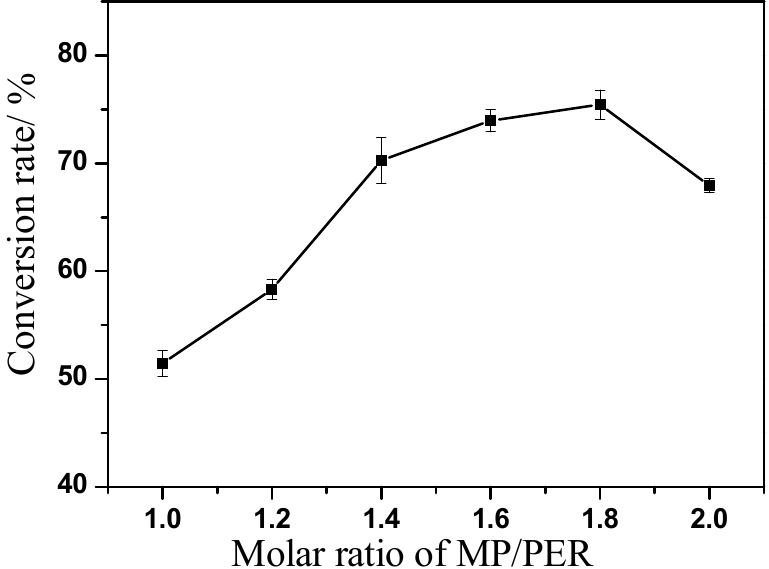
Figure 3. The conversion rate of the reactive extruding between MP and PER with different molar ratios.